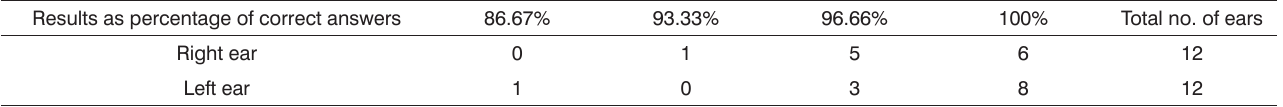
Table 1. Analysis of results of the duration pattern test, per ear, for all participants (N=12). Results as percentage of correct answers